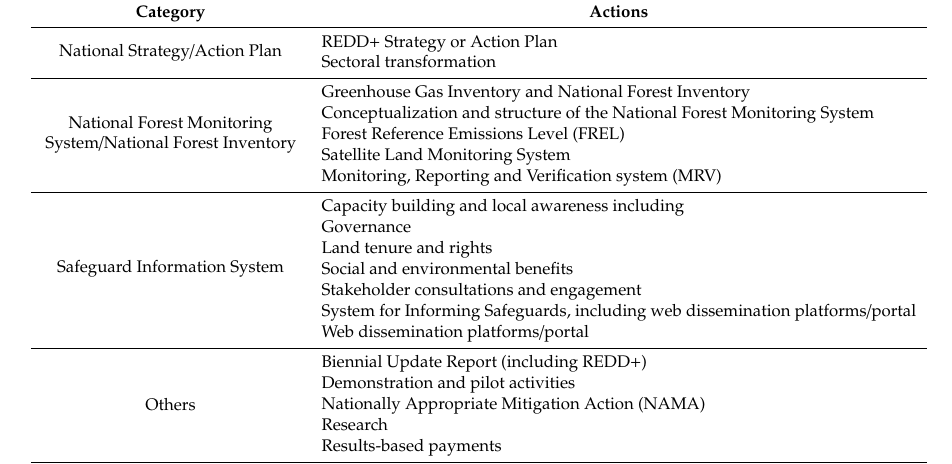
Table 2. Types of actions for Bilateral REDD + financing reported to FAO Voluntary REDD + Database (VRD).